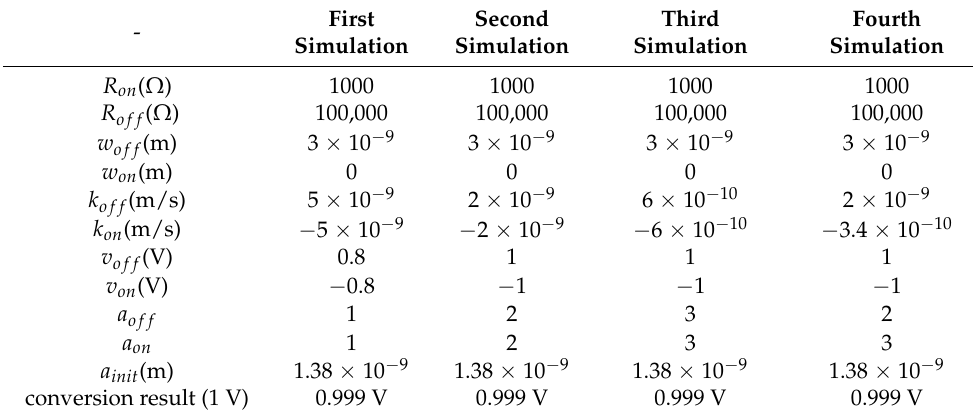
Table 1. The parameter settings of the memristor.